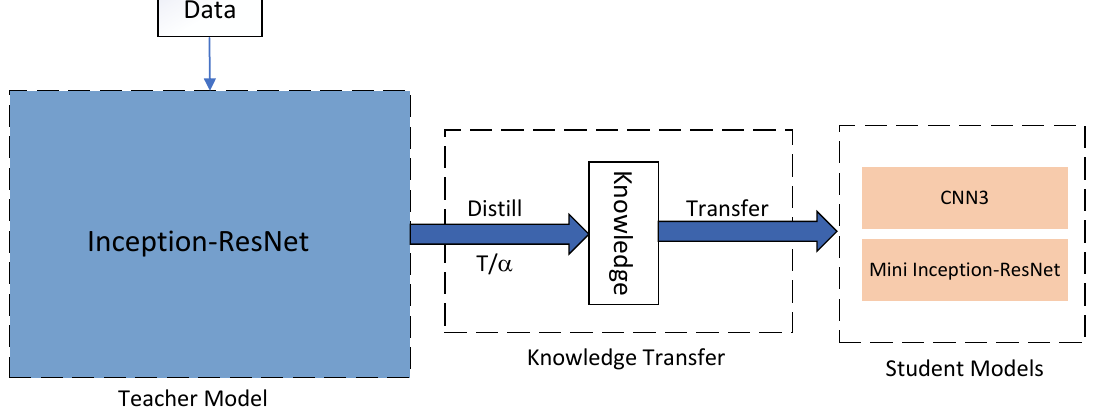
Figure 4. The generic teacher–student framework for knowledge distillation